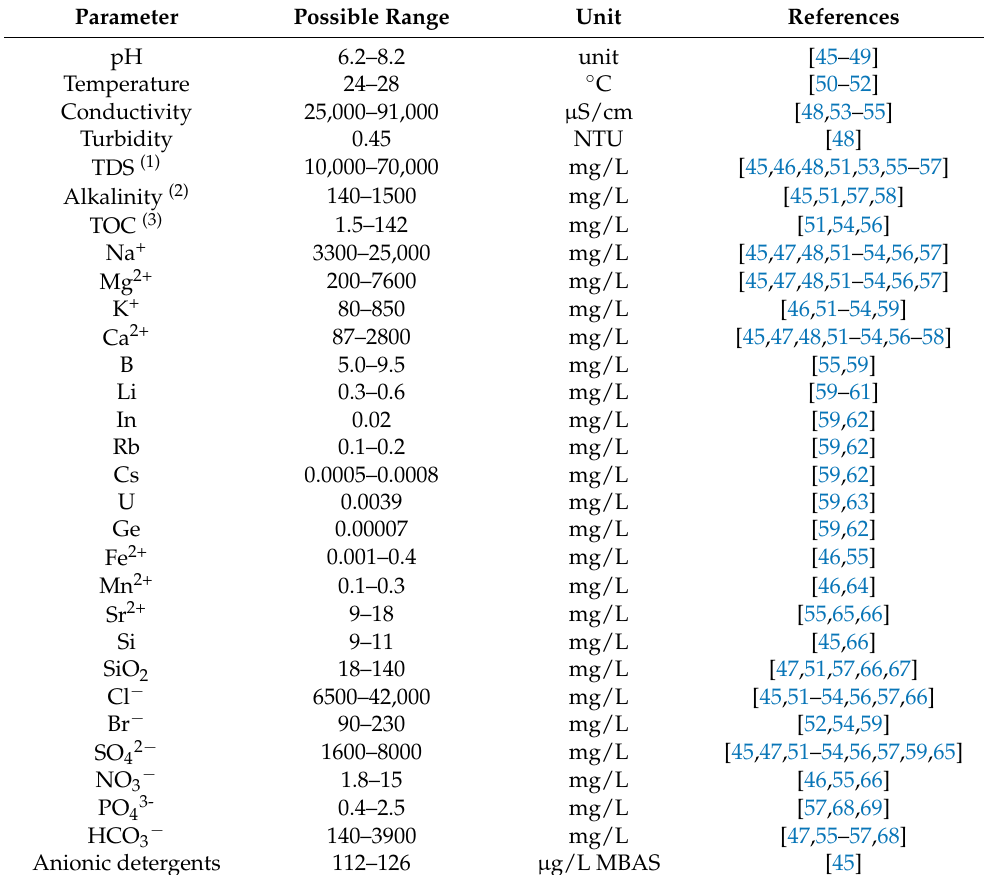
Table 2. Possible range of the main physicochemical parameters present in